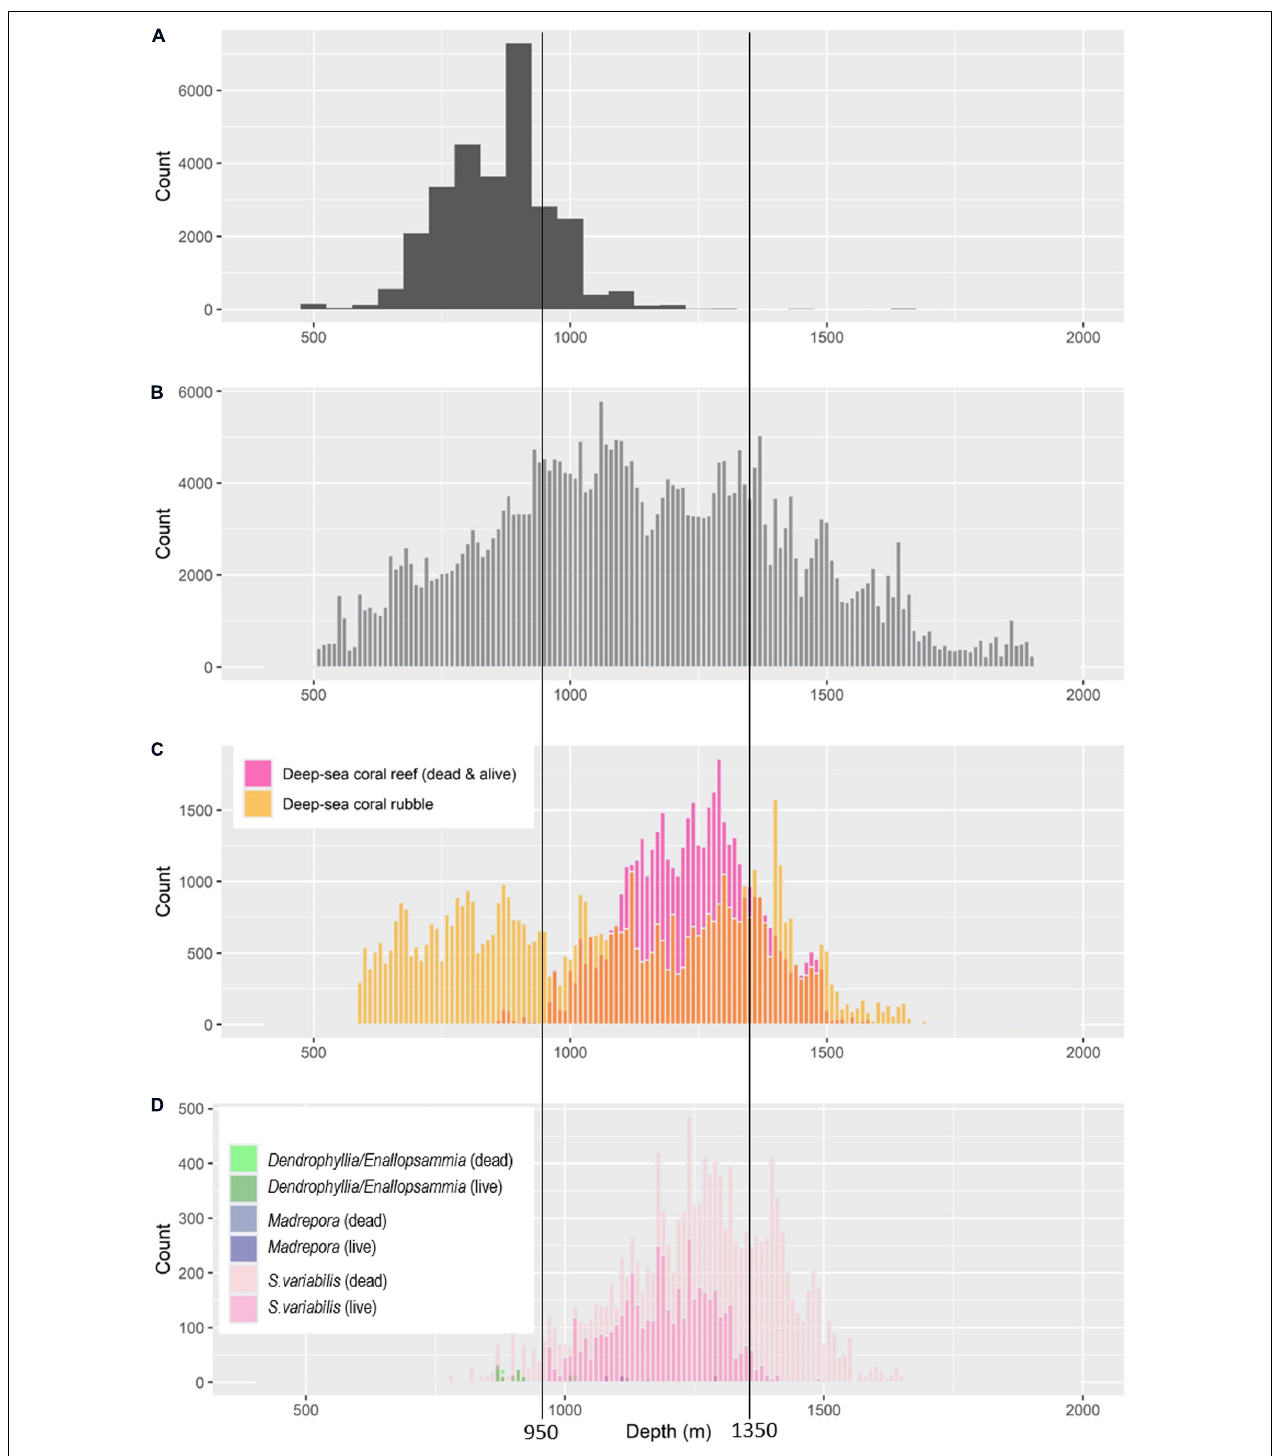
FIGURE 4 | Depth ranges of parameters relevant to understanding trawling impacts: (A) frequency of the average depth of trawl operations reported in commercial logbooks; (B) frequency of combined observations from video imagery to show the depth range sampled; (C) depth ranges of dead and live matrix, and rubble, for all framework-building scleractinian corals combined based on frequency of observations in video imagery (D) depth ranges of dead and live matrix of Solenosmila variabilis , Dendrophyllia/Enallopsammia spp. and Madrepora oculata based on frequency of observations in still images. Vertical lines mark the core distribution of live coral reef formed by S. variabilis (approximating 95% records, and as mapped in Williams et al., 2020).